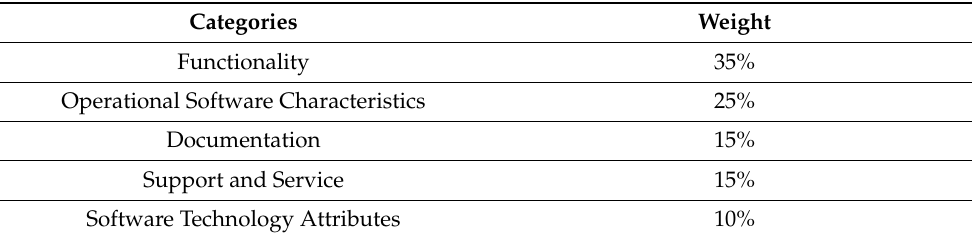
Table 2. Assigning weights to